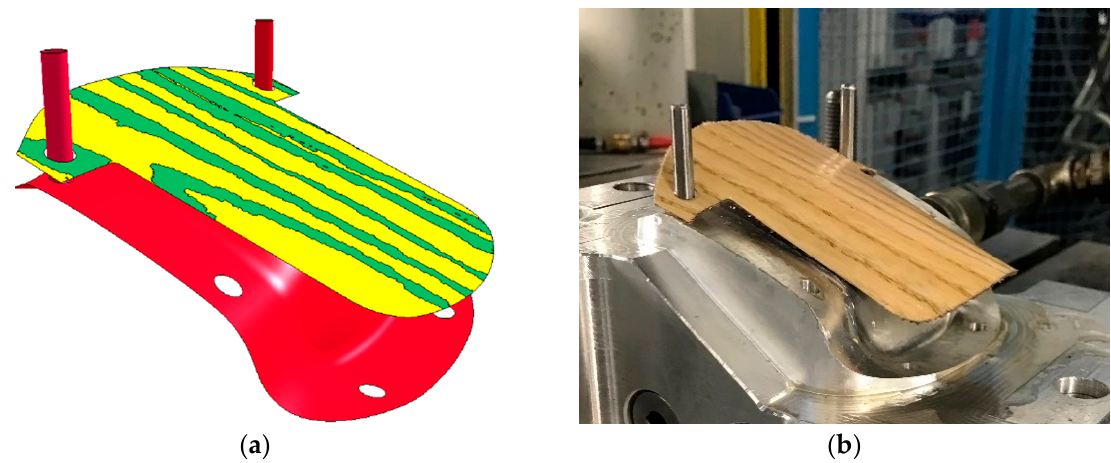
Figure 7. ( a ) Balance position of the blank from the gravity simulation ( t plot = 1.5 s); ( b ) initial position in the true forming process.